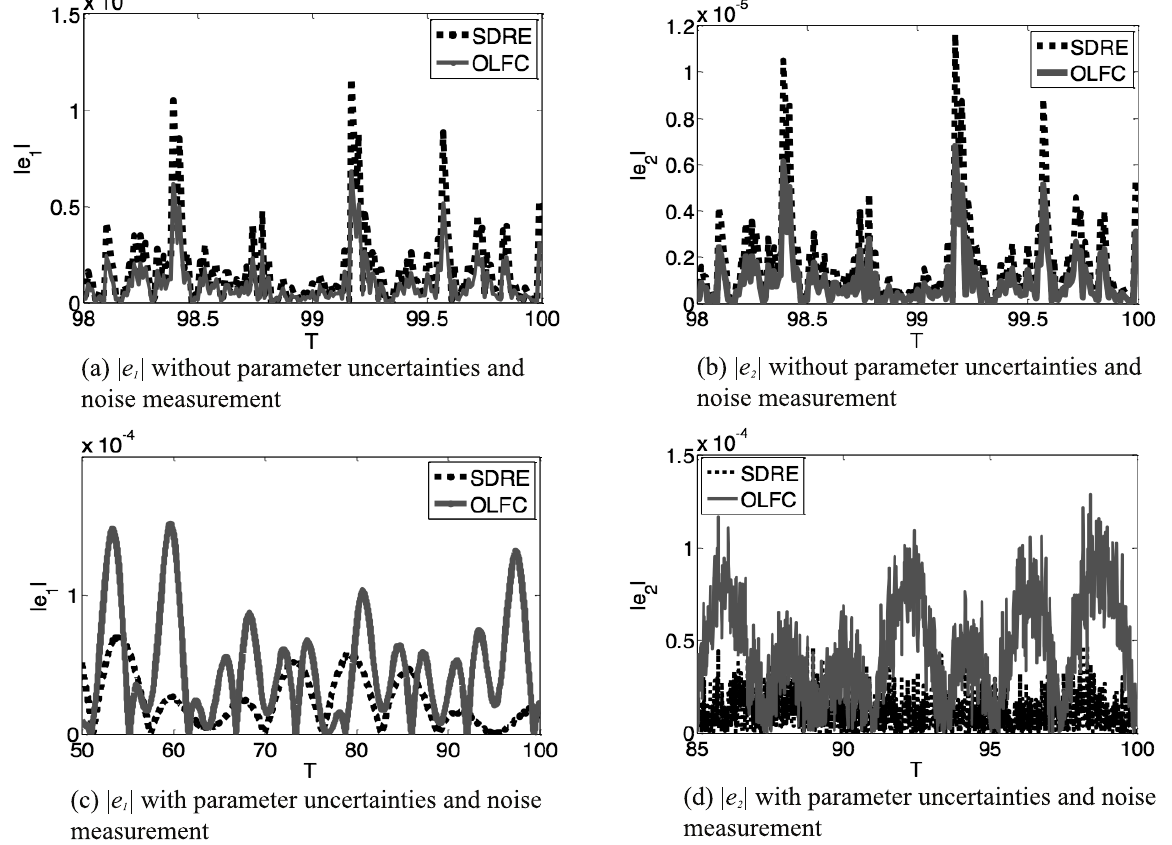
Fig. 6. Comparing OLFC and SDRE in the presence of parameter uncertainties and noise